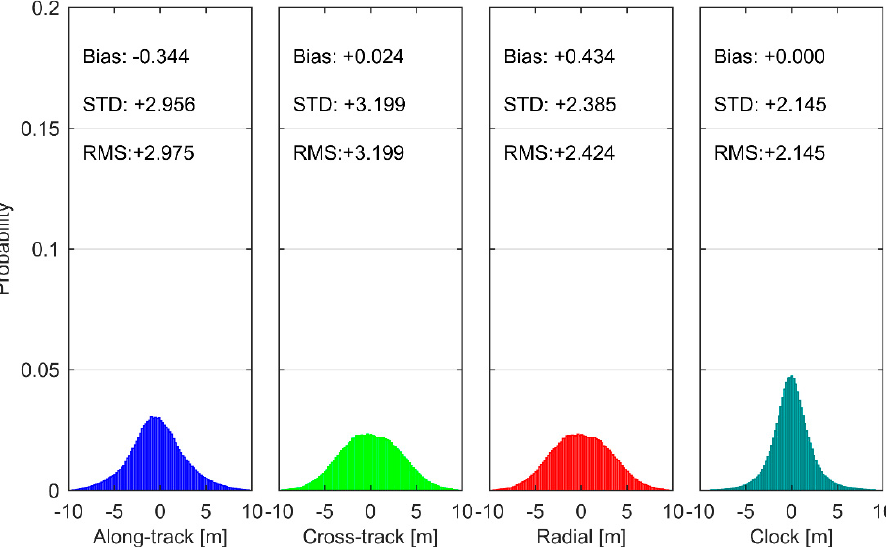
Figure 9. The distribution of SBAS-derived orbit and clock errors for GAGAN PRN 128.